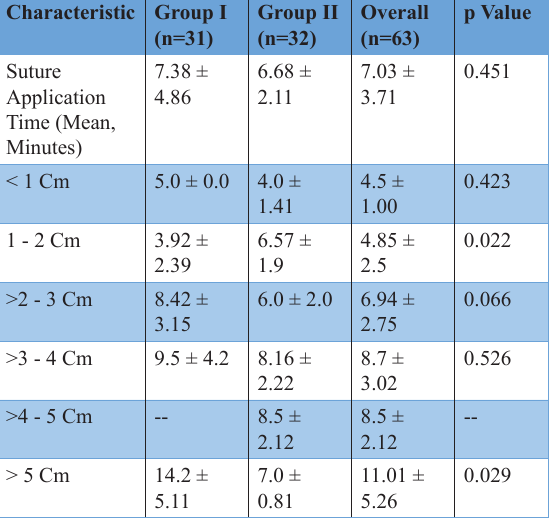
Table 1. Suture application time per wound length for each